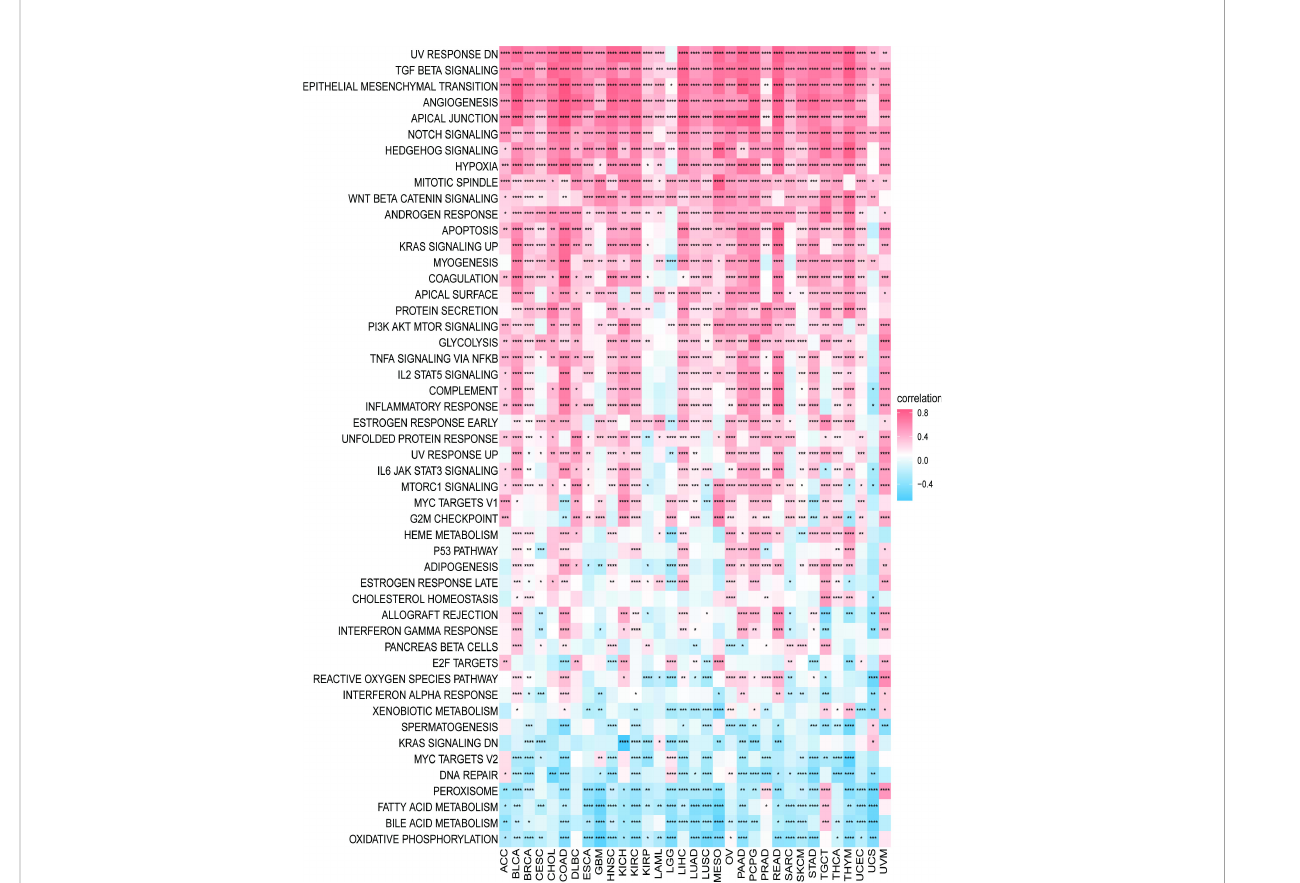
FIGURE 7 GSVA results. Results of HALLMARK enrichment analysis of PXDN in different tumors. Red and blue represent positive and negative correlations, respectively, while white represents p > 0.05. *p < 0.05, **p < 0.01, ***p < 0.001, ****p <